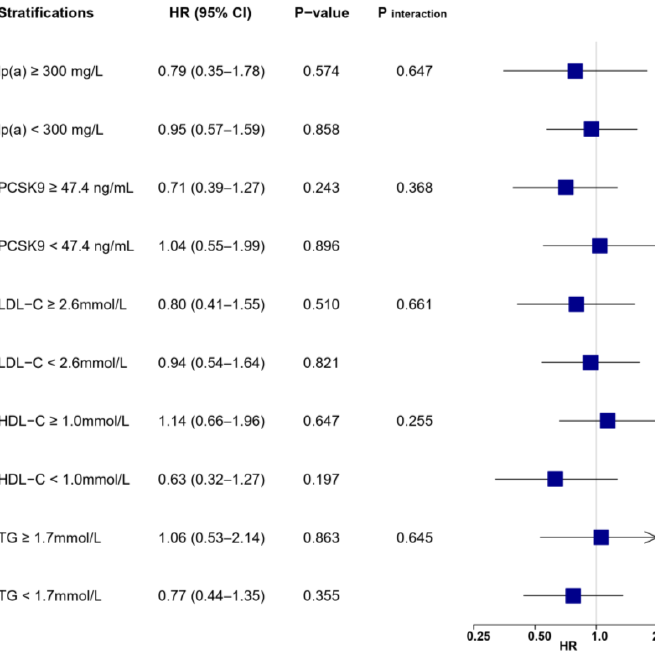
Figure 8. Associations between LL-37 and the risk of recurrent MI according to lipid profile values. Multivariable Cox regression was adjusted for variables with p < 0.1 in univariable analysis